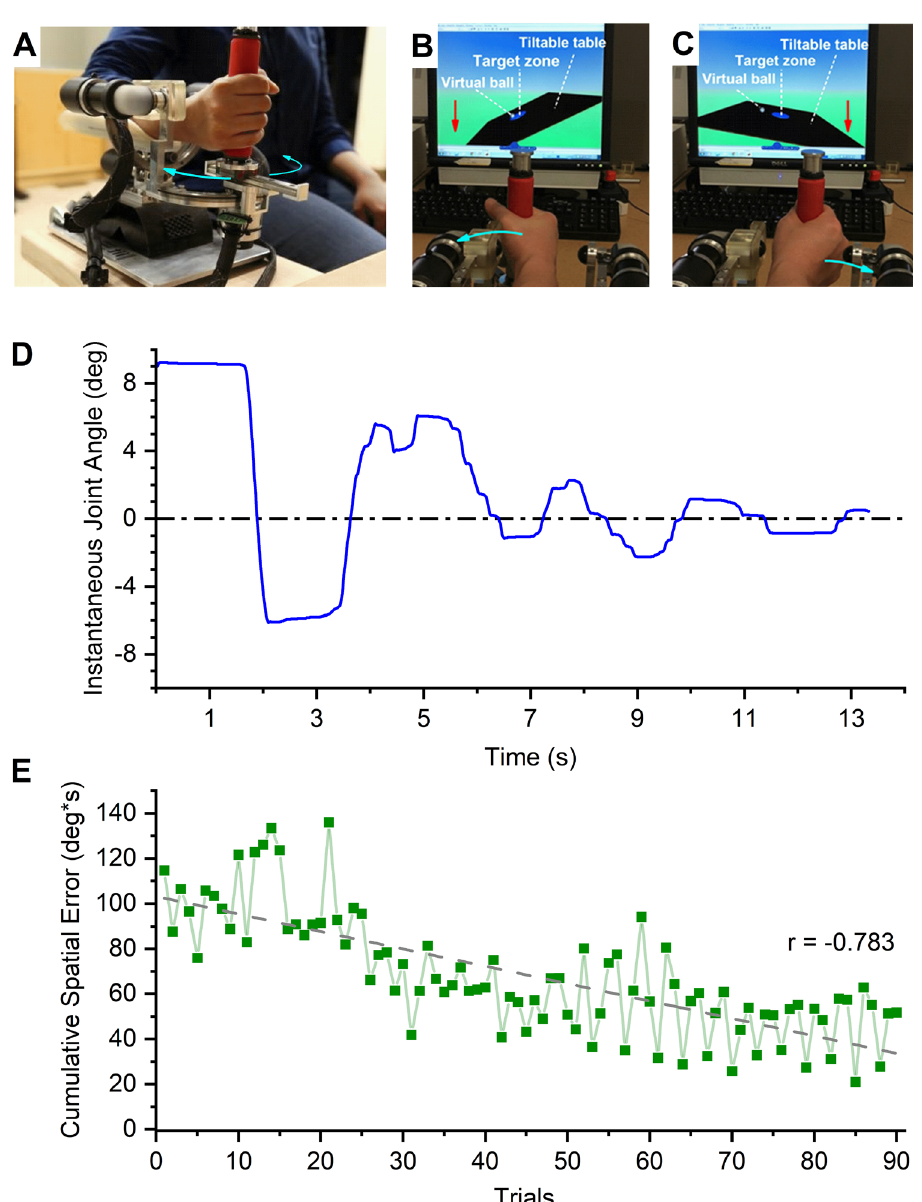
Figure 1. Wrist robot and visuomotor training. ( A) Antero-lateral view of the wrist robot with a participant’s forearm positioned in the support splint, hand holding the device handle. ( B) Visual display of the task. Goal is to bring the ball rolling on the virtual table into the target zone. Wrist flexion tilts the virtual table to the left. ( C) Wrist extension tilts the virtual table to the left. ( D) Instantaneous wrist flexion/extension joint angle changes during a single training trial from one of the participants. ( E) Learning effect on movement trajectory formation as measured by the Cumulative Spatial Error (CSE). Each data point represents the mean CSE of all participants for a particular trial. Note the decline of CSE over successive trials. Dashed line indicates the fit of a linear regression model. r coefficient of